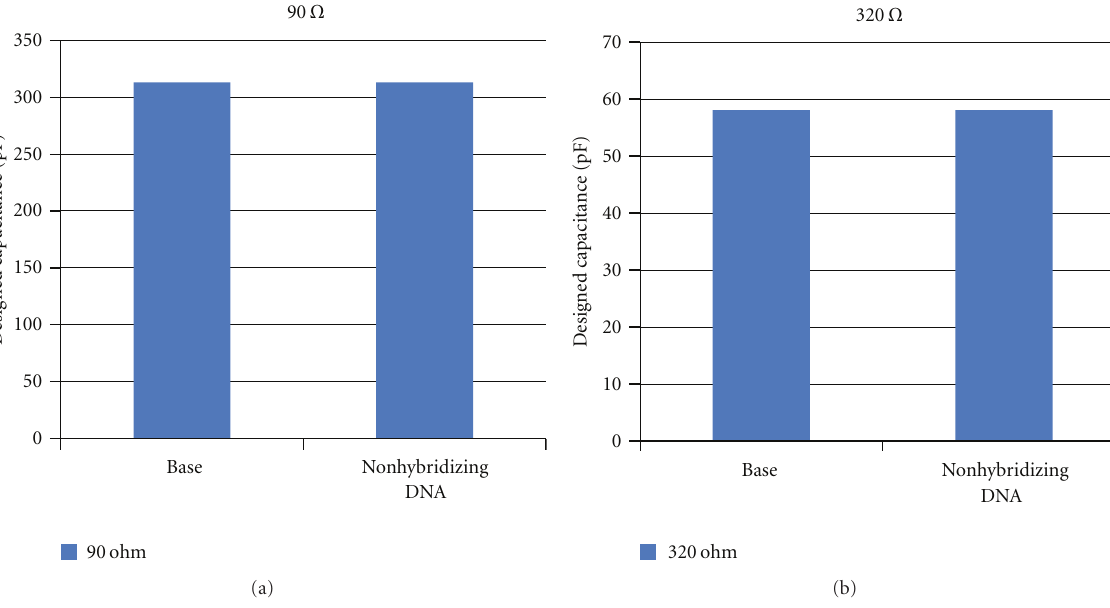
Figure 10: (a) Designed capacitance remains the same from BASE to hybridized DNA for sensor having 90 Ω bare resistance. (b) Designed capacitance remains the same from BASE to hybridized DNA for sensor having 320 Ω bare